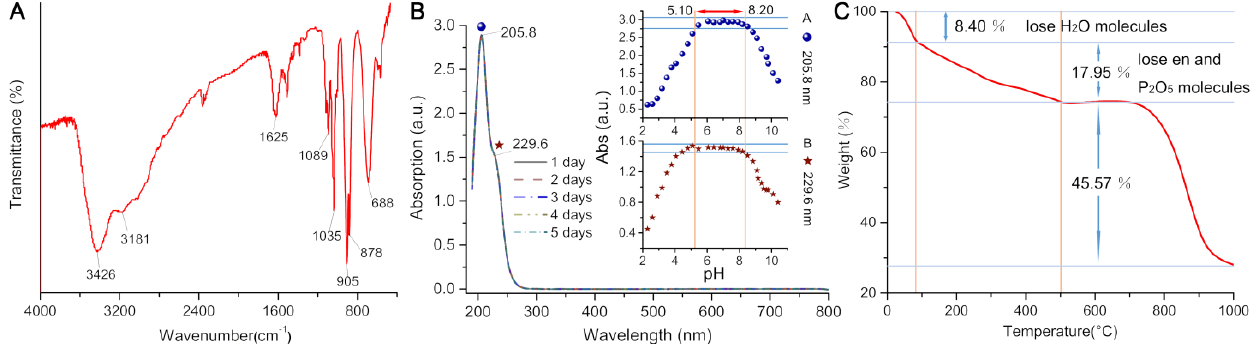
Figure 3. ( A ) IR spectrum for (H 2 en) 3 [Mn(H 2 O) 4 ][Mn(H 2 O) 3 ] 2 [P 2 Mo 5 O 23 ] 2 · 14.5H 2 O (MnPM). ( B ) The UV-vis spectrum of MnPM in ultrapure water. Additionally shown: the variation of the peak intensities with pH of the solution (inset figure). ( C ) The thermogravimetric analysis (TGA) curve of MnPM from 25 to 1000 °C .